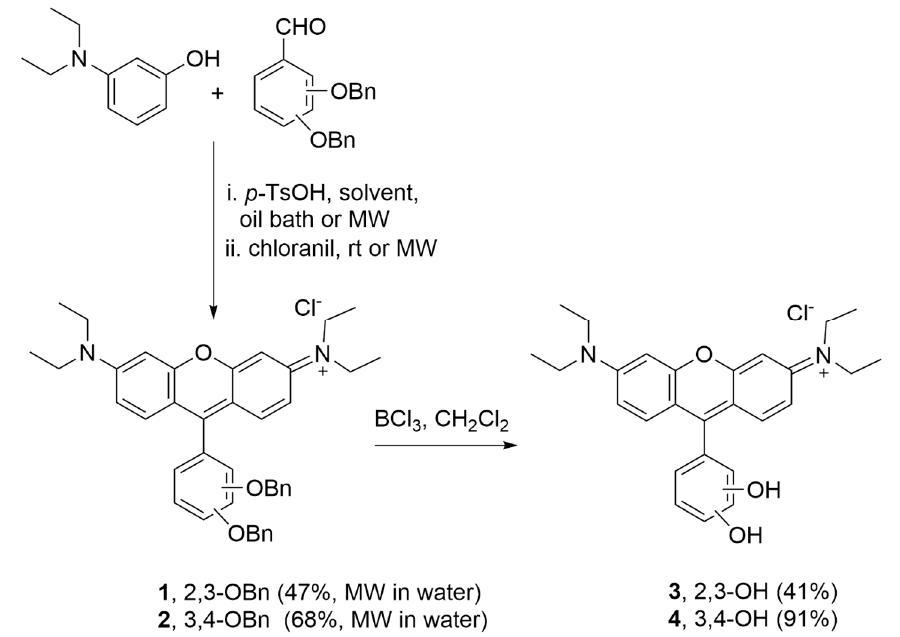
Table 1. Photophysical properties ( λ max abs , λ max em , ε , Stokes shift, and Φ F ) of rosamines 1 – 4 and RhB in chloroform, acetonitrile, and methanol at 25